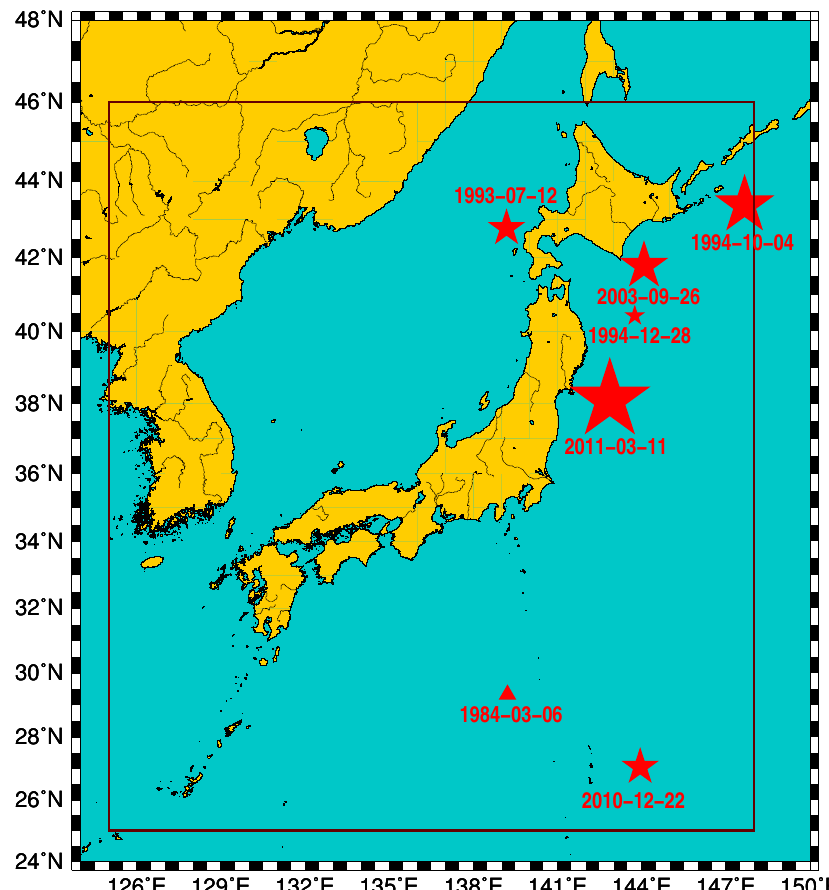
Figure 3. EQs of magnitude 7.6 or greater whose epicentres (stars) lie within N 46 1 January 1984 until the M 9 Tohoku EQ. The triangle is a deep EQ that occurred on 6 March 1984. Taken from Ref.